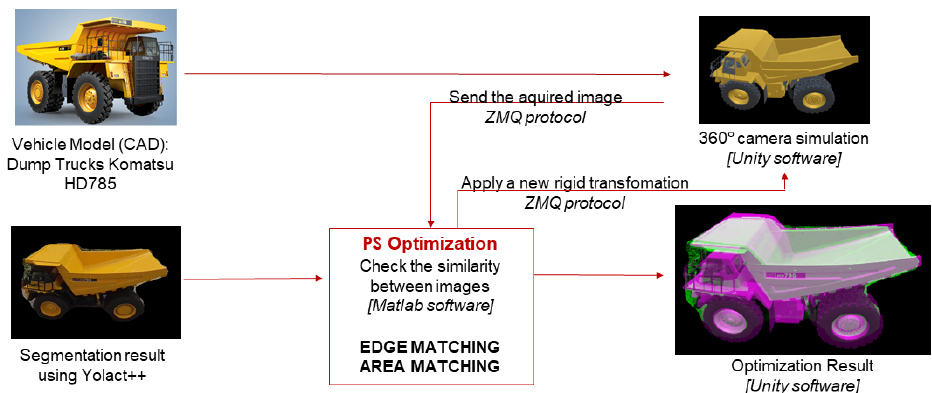
Figure 3. Scheme of the pose detection